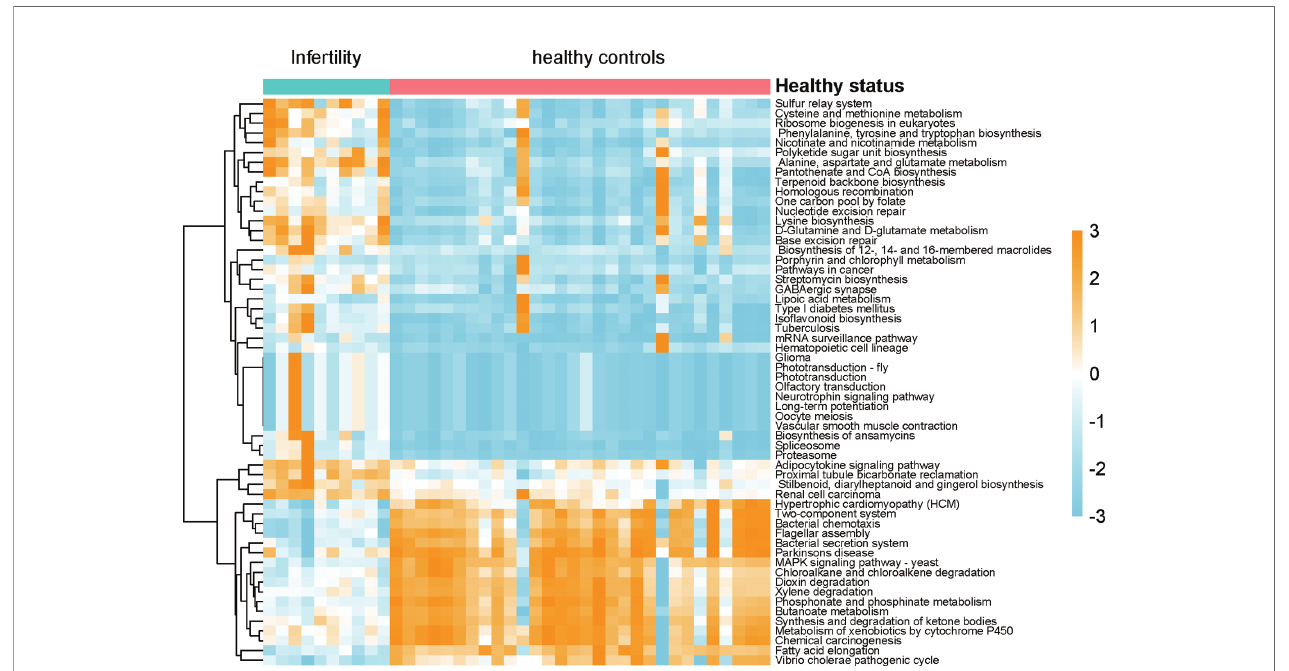
FIGURE 5 | The differences of biological function between infertility and healthy controls of reproductive-aged women. The pathways were predicted by the relative abundances of microbiota, Wilcoxon test was used the compare the differences, and the resulting p -values were adjusted with false discovery rate (FDR)